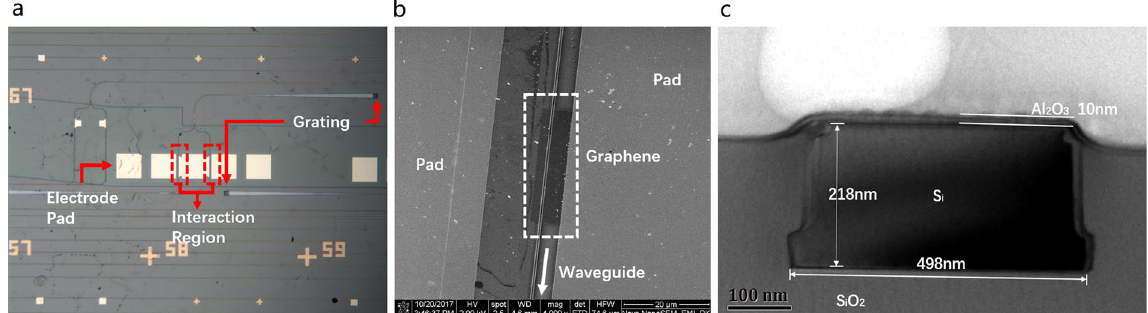
Figure 3. ( a ) Optical images of device ( b ) SEM planform image for interaction region ( c ) TEM image for the cross section of the graphene-oxide-silicon waveguide.